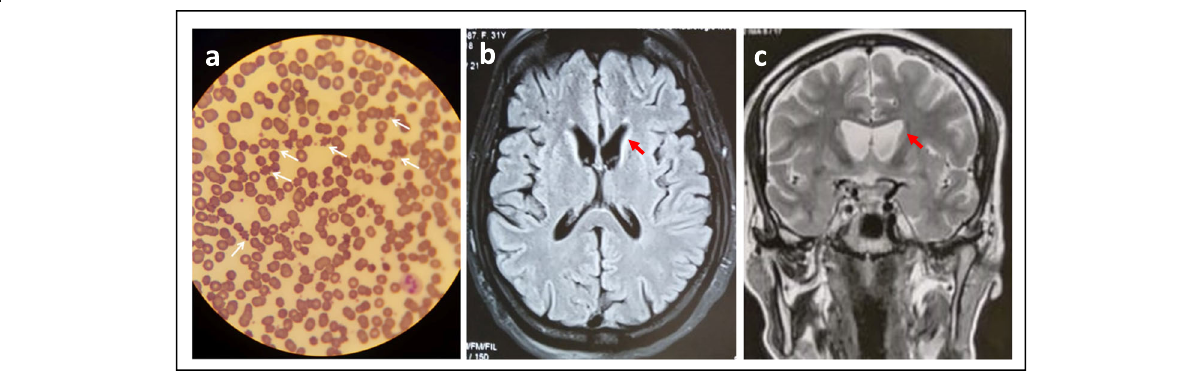
Fig. 2 Biological and neuroimaging features of patient IV.2 presenting with choreoacanthocytosis. a Acanthocytes on peripheral blood smear (white arrows); b, c Atrophy of the caudate nucleus head on axial and coronal view respectively (red